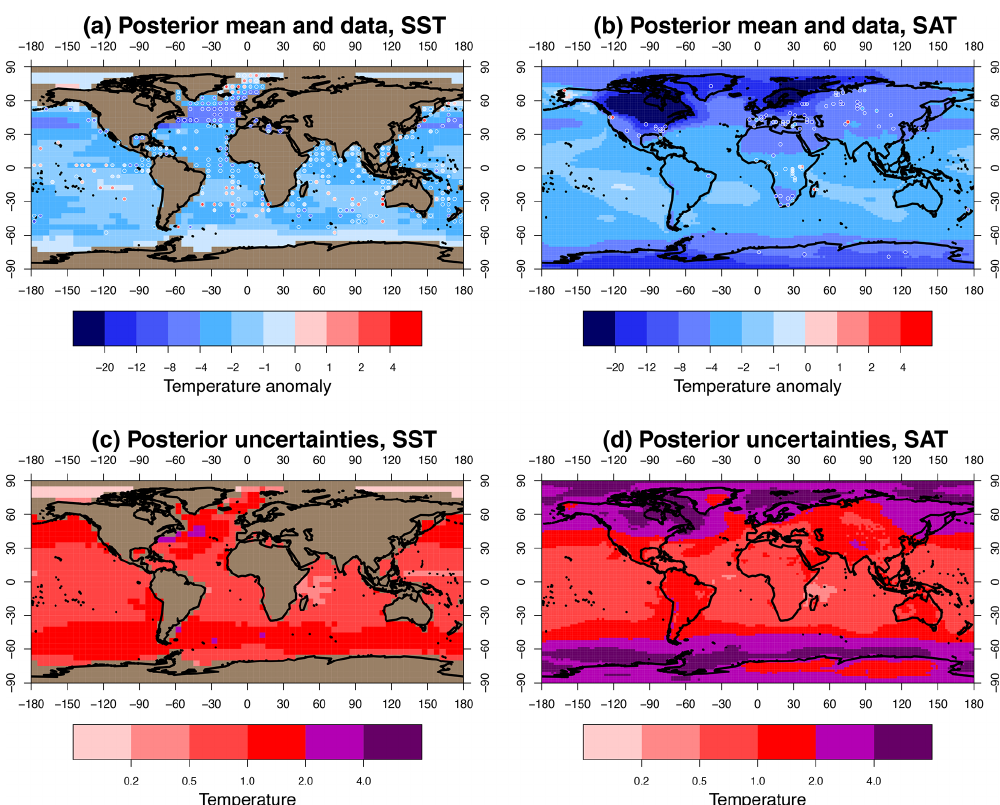
Figure 4. Posterior uncertainties in (c) and (d) . SST (a, c) . SAT (b, d)